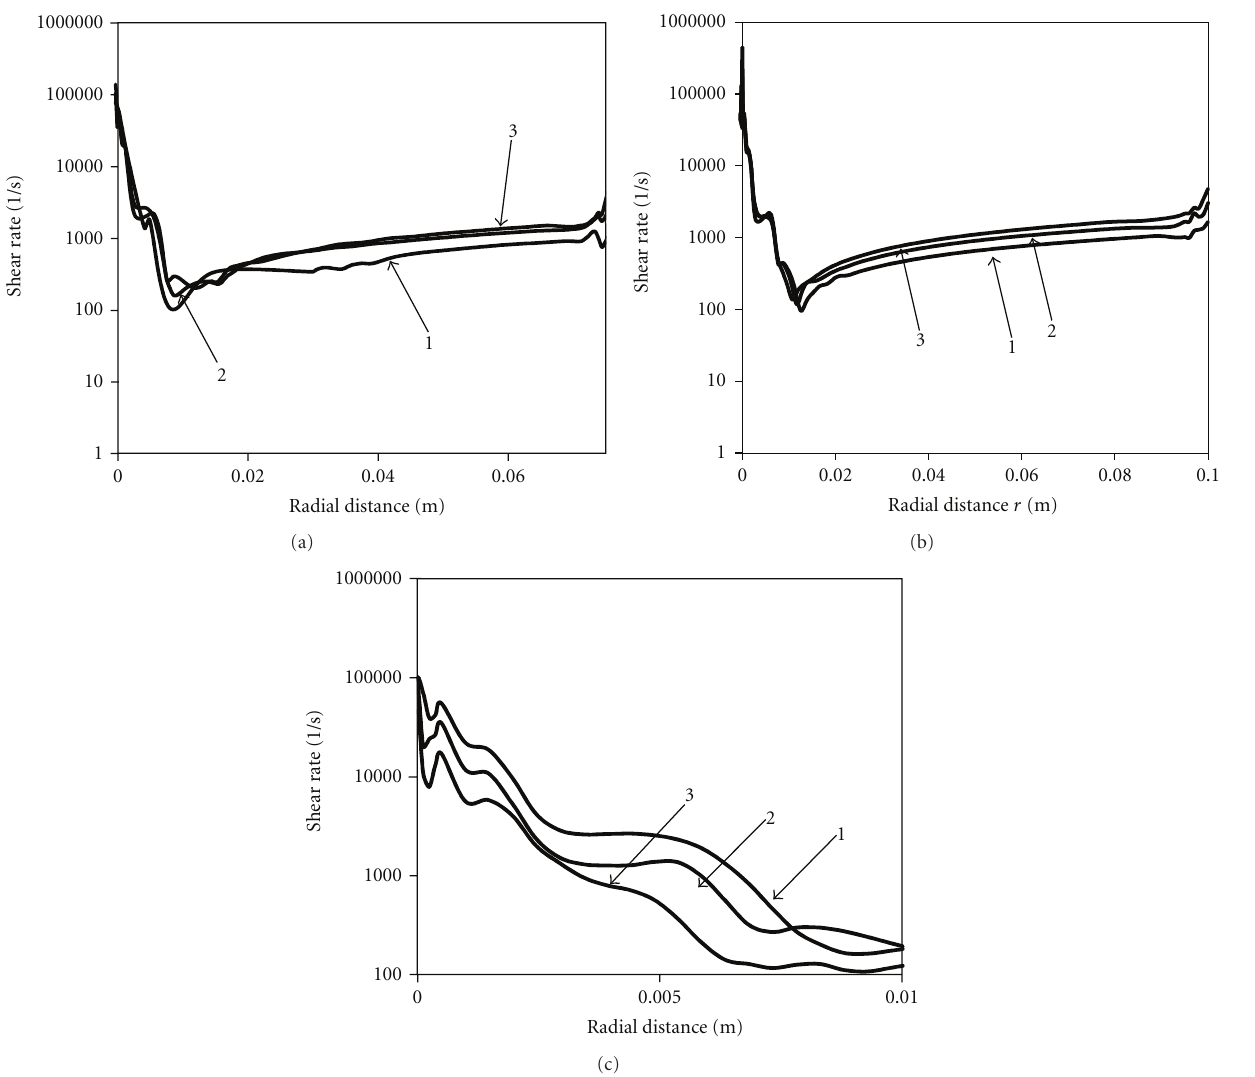
Figure 4: Variation of shear rate along radial coordinate [ z = 0 . 00075 m]. (a) Disc diameter: 0.15 m, flow rate: 300 mL/min, line 1: 600 rpm, line 2: 1000 rpm, line 3: 1400 rpm. (b) Disc diameter: 0.20 m, flow rate: 300 mL/min, line 1: 600rpm, line 2: 1000 rpm, line 3: 1400 rpm. (c) Disc diameter: 0.15 m, rotation speed: 1000 rpm, line 1: 300mL/min, line 2: 190 mL/min, line 3: